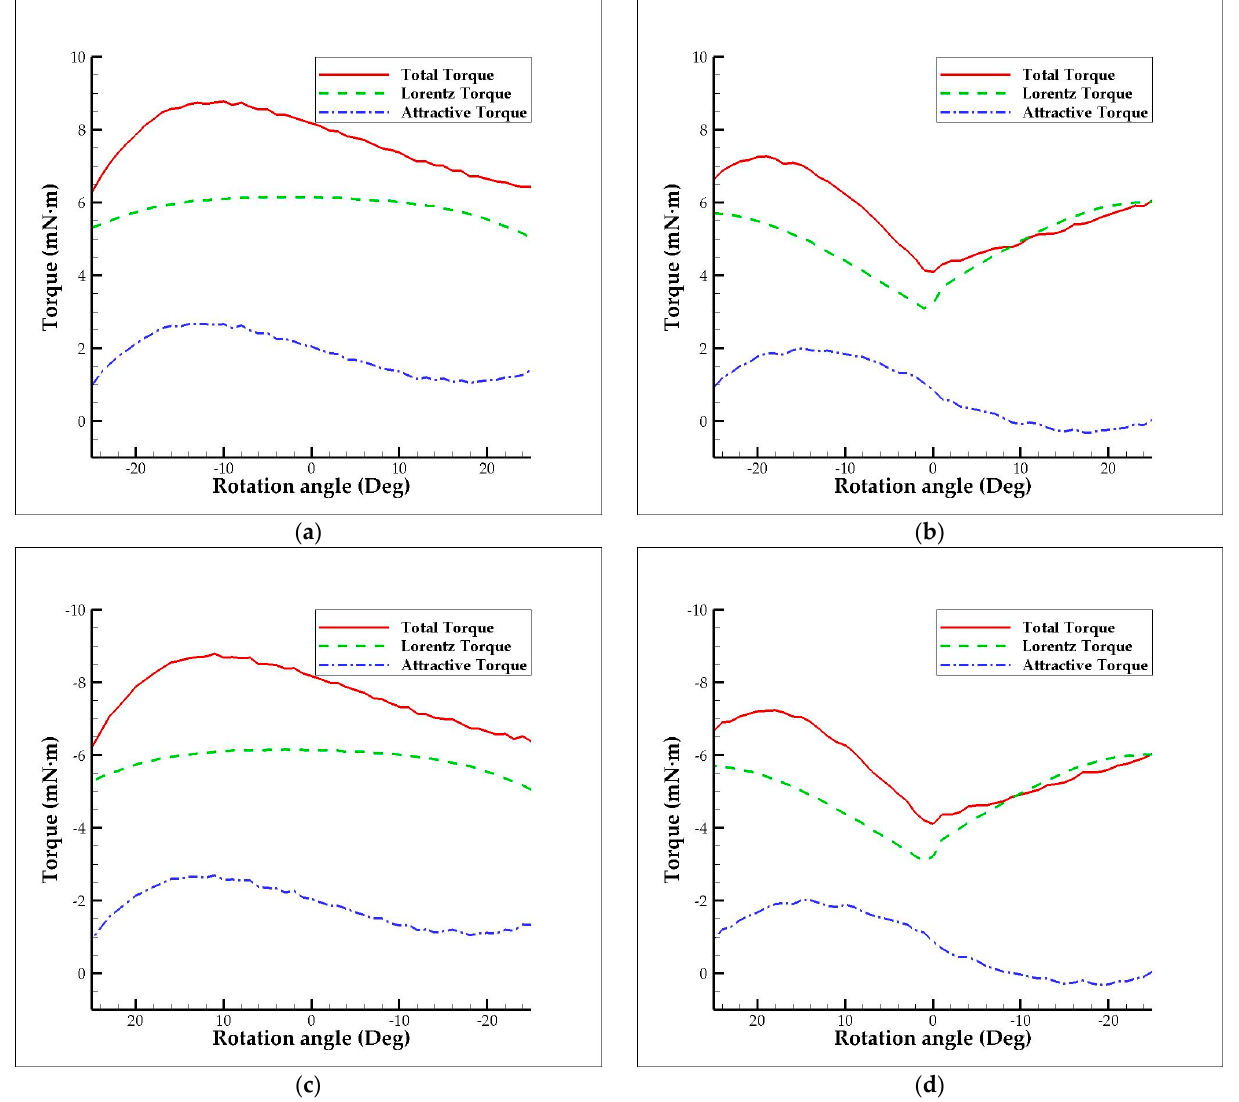
Figure 11. Numerical results obtained for the torque output with respect to different rotation angle of, respectively, ( a ) original and ( b ) proposed 3-DOF spherical motor rotating from − 25° to +25° in a counter-clockwise direction and ( c ) original and ( d ) proposed 3-DOF spherical motor rotating from +25° to − 25° in a clockwise direction with reverse axis direction.